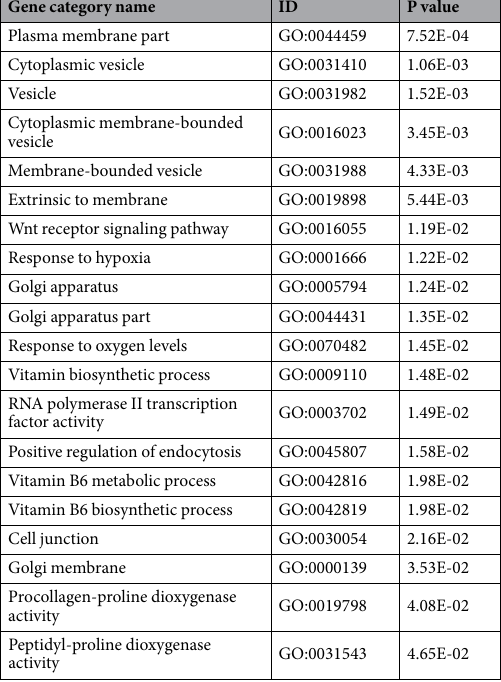
Table 2. Gene ontology enrichment analysis of target genes of differently expressed miRNAs in KBD vs.